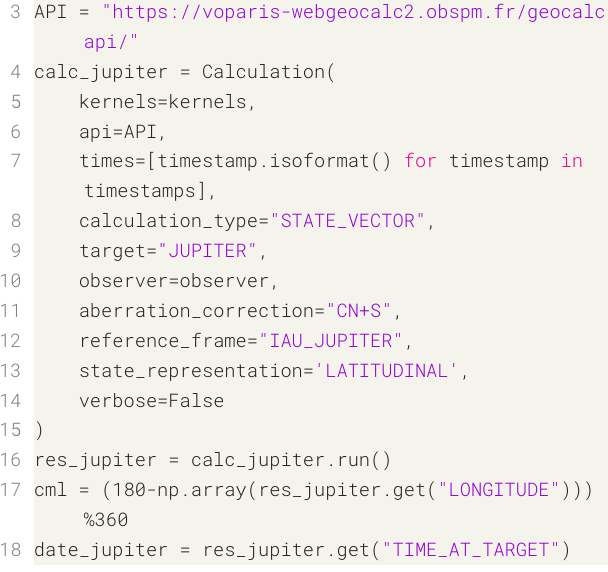
server as CDF 7 files, and are accessed using the spacepy . PyCDF (Niehof et al., 2022) module. The application also uses the Pillow 8